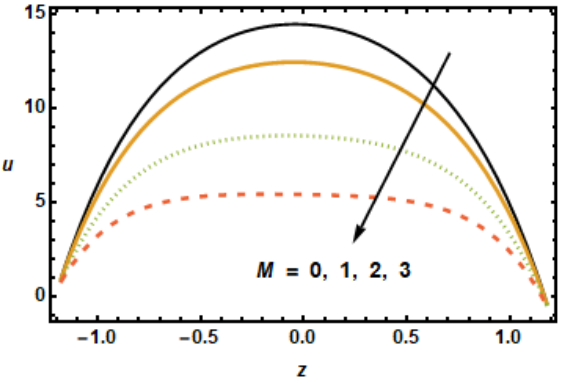
Figure 2. Effects of Hartmann number M on u .